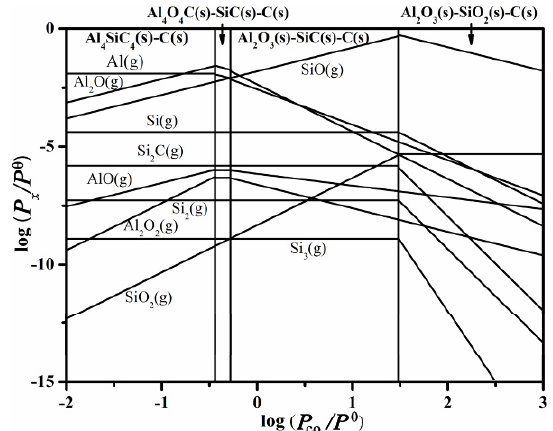
Fig. 5 Equilibrium partial pressures of gases formed in the Al–Si–C–O system.